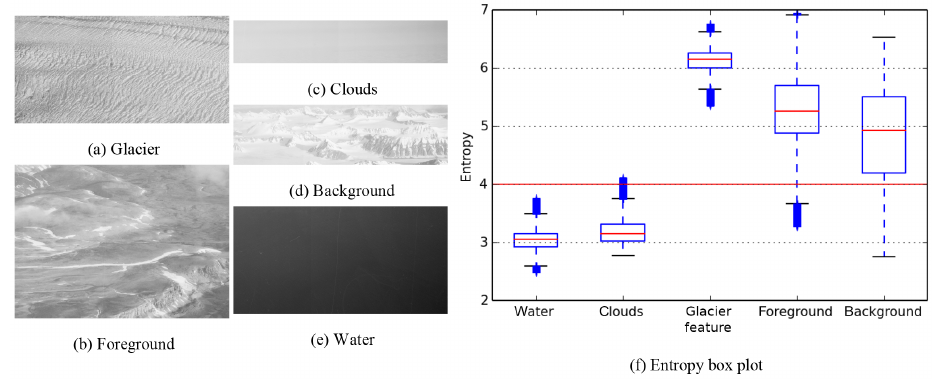
Figure 4. Entropy response values for samples of different terrain features.